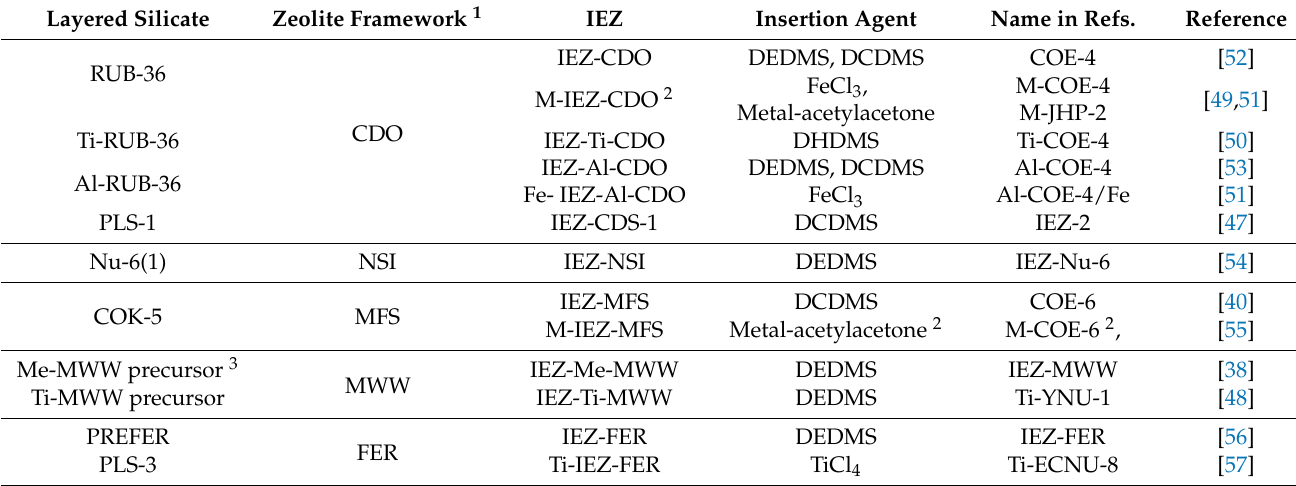
Table 2. Published synthesis routes involving IEZs of layered